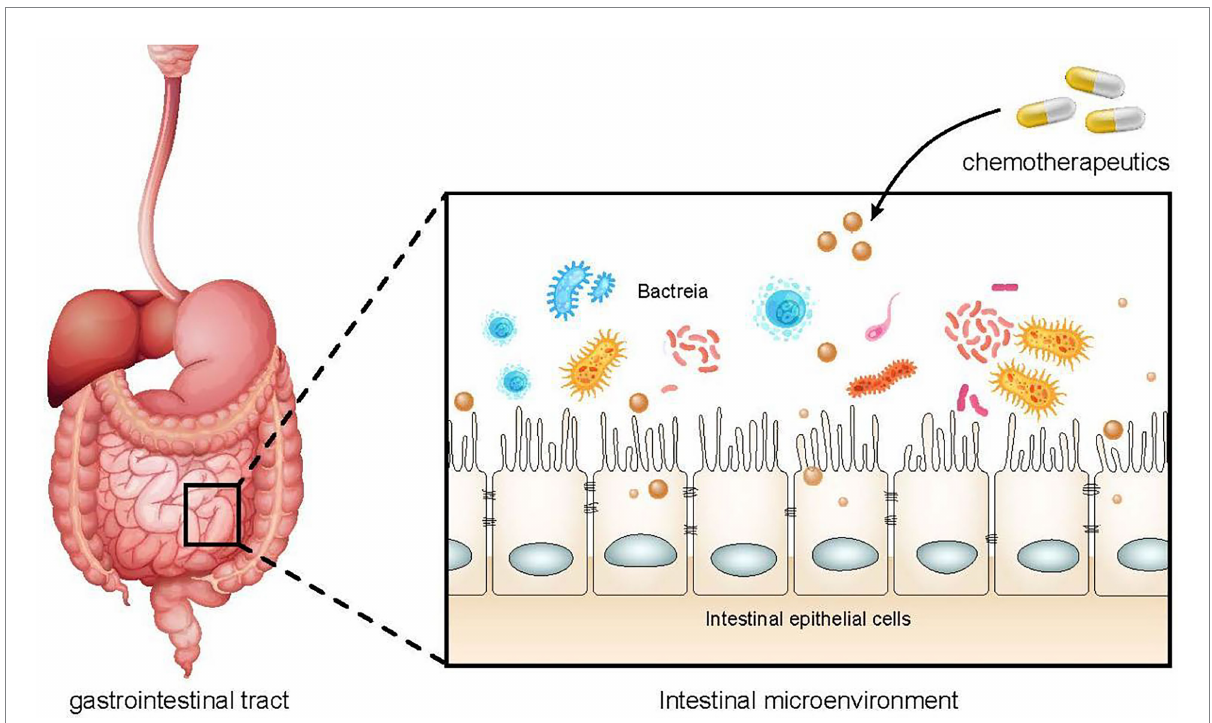
FIGURE 1 The effect of chemotherapy drugs on gut microbiota. The use of chemoherapeutic drugs can damage intestinal epithelial cells, alter intestinal permeability, and reduce the protective function of the intestinal barrier, resulting in intestial dysbiosis and an increased risk of